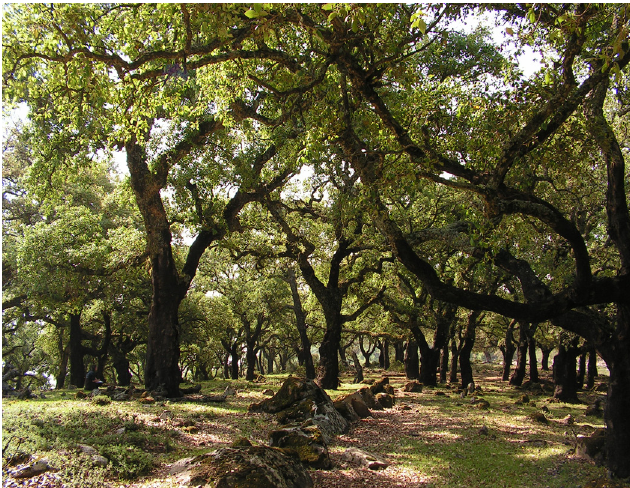
Figure 2: Sacred grove with over aged Cork Oak (Quercus suber) (near landscape section C2, NW Morocco).